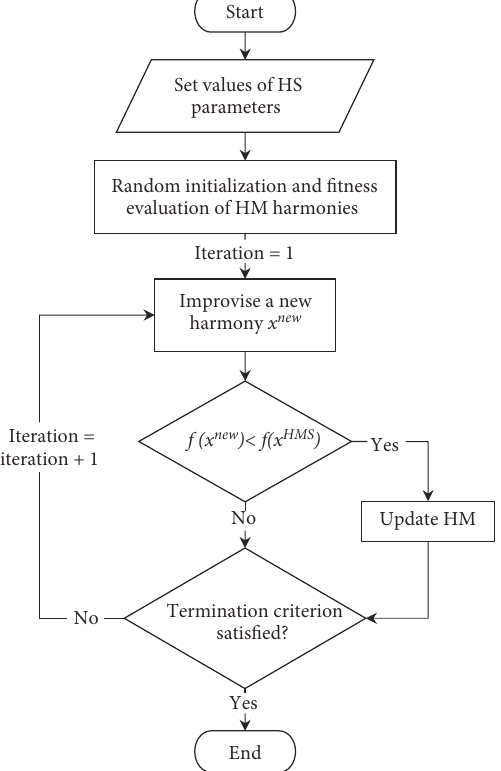
Figure 2: Flowchart of harmony search